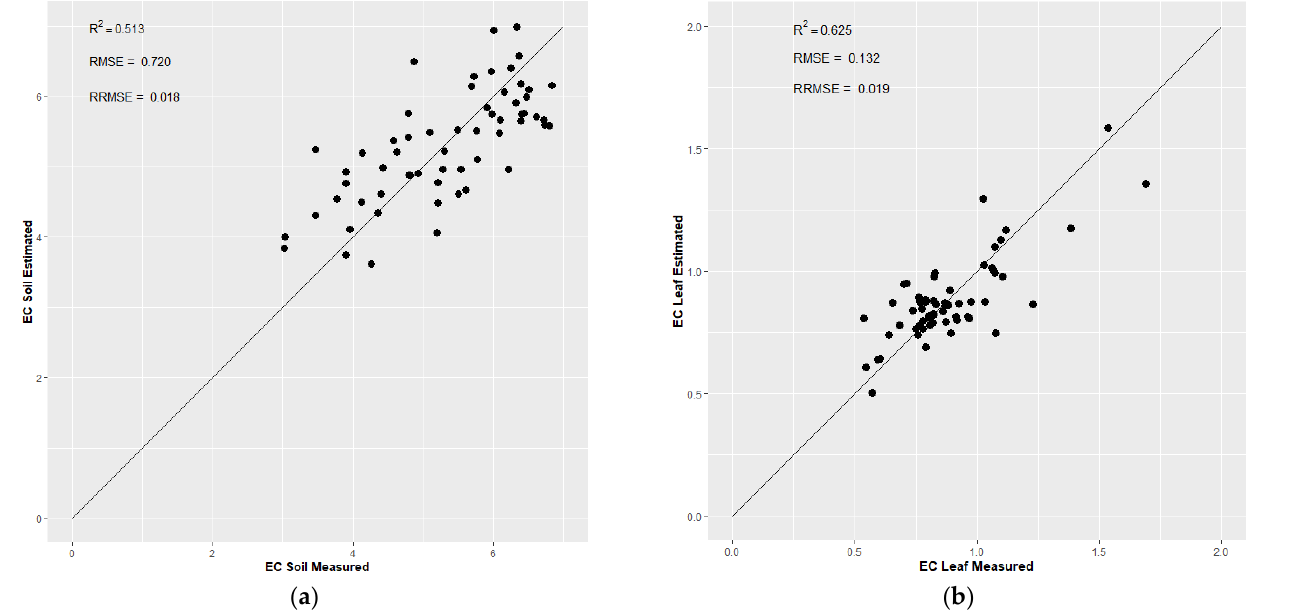
Figure 1. Best ( a ) soil and ( b ) leaf prediction models.